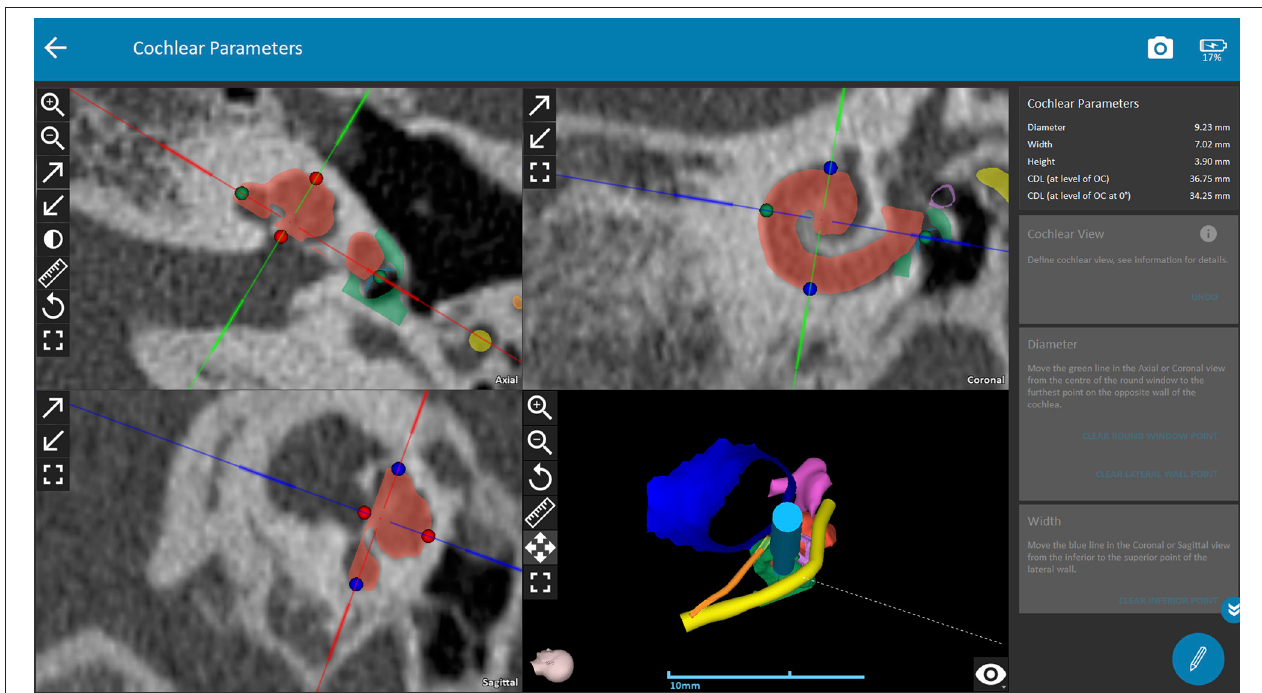
FIGURE 1A | Planning procedures with OTOPLAN. Cochlear view for assessing the software-guided cochlear parameters. The observer defines the cochlear view which corresponds to the center of the modiolus, the basal turn of the cochlear, and the round window in the axial, coronal and sagittal view. The diameter, height, width and length of the cochlear are then defined by the observer based on instructions of the software. Consequently, the software automatically calculates the cochlear parameters. The right lower picture displays a 3D model of the planned trajectory. Green dots (selection of round window and lateral wall), blue dots (selection of superior and inferior wall in coronal view), red dots (inferior and superior walls of cochlear in axial view), red shading (cochlear segmentation automatically calculated by the software), green shading (bony overhang automatically calculated by the software), yellow shading (facial nerve), dark blue shading (external ear canal), pink shading (ossicles), orange shading (chorda tympani), light blue shading (drill in position of the automated